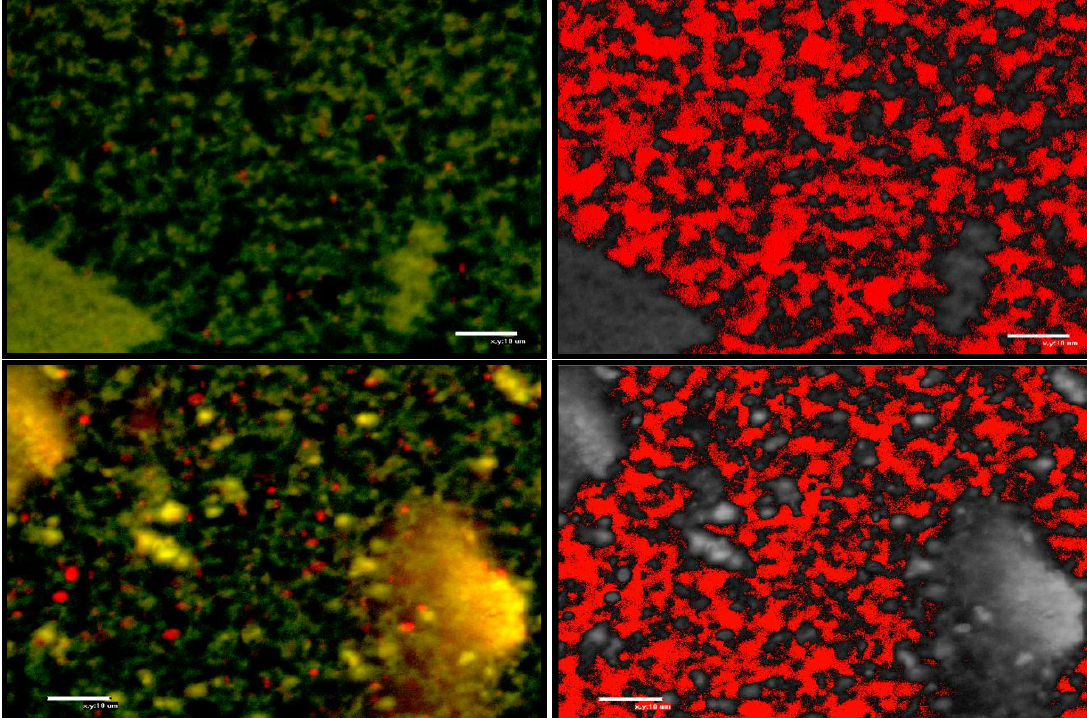
Figure 6. Confocal laser scanning microscope (Nikon C1) images taken of gels of control skim milk (top) and skim milk + WBAP (0.6 g/100 mL; bottom) at 60× with a zoom of 2.31×; proteins were dyed green and phospholipids are red. Images on the right were processed with ImageJ to color the clusters red. Scale bar value = 30